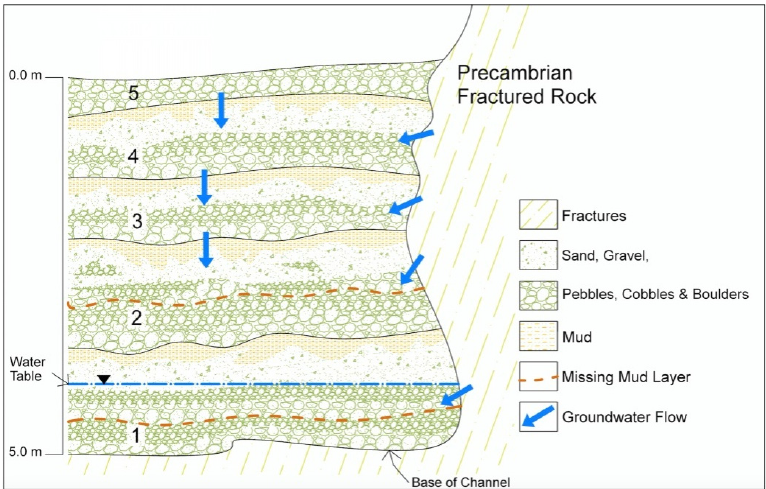
Figure 7. Stacked sequence of fining upward beds showing sediment composition and hydraulic connection to the perimeter fractured rock. Note that the vertical scale is what would be expected if